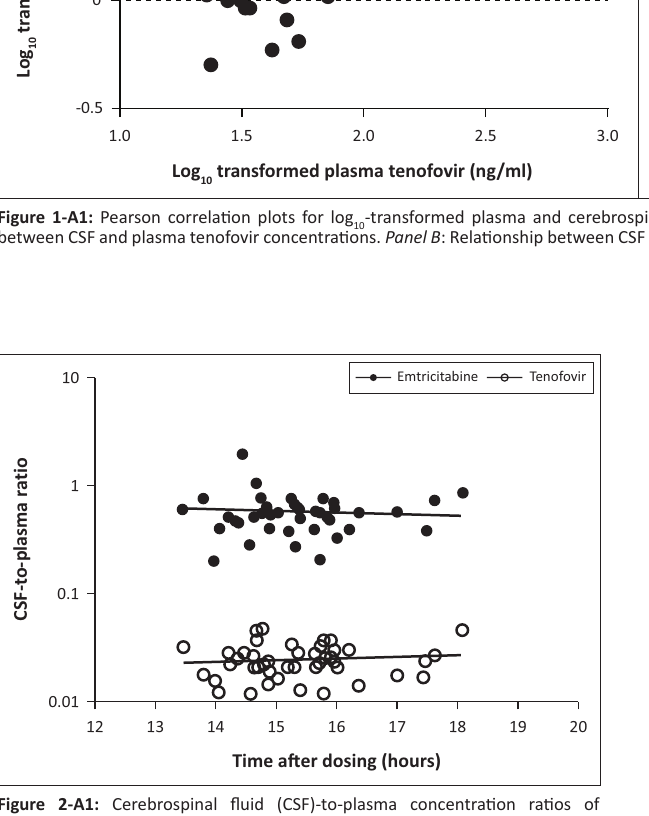
Figure 2-A1: Cerebrospinal fluid (CSF)-to-plasma concentration ratios of detectable pairs of plasma and CSF samples versus time after dosing. The lines are linear regression lines and were not statistically